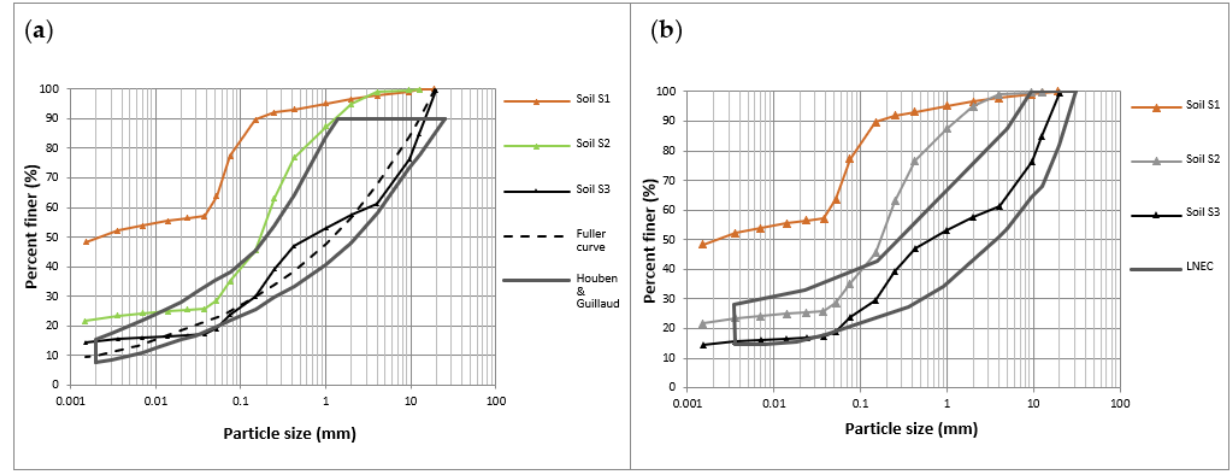
Figure 4. Comparison between the PSD curves of the soils and the envelopes for rammed earth construction recommended by: ( a ) Houben and Guillaud [44]; and ( b ) the Portuguese National Laboratory of Civil Engineering [45]. Table 3. Theoretical and experimental values of the components in the earth mixture for pisé constructions.